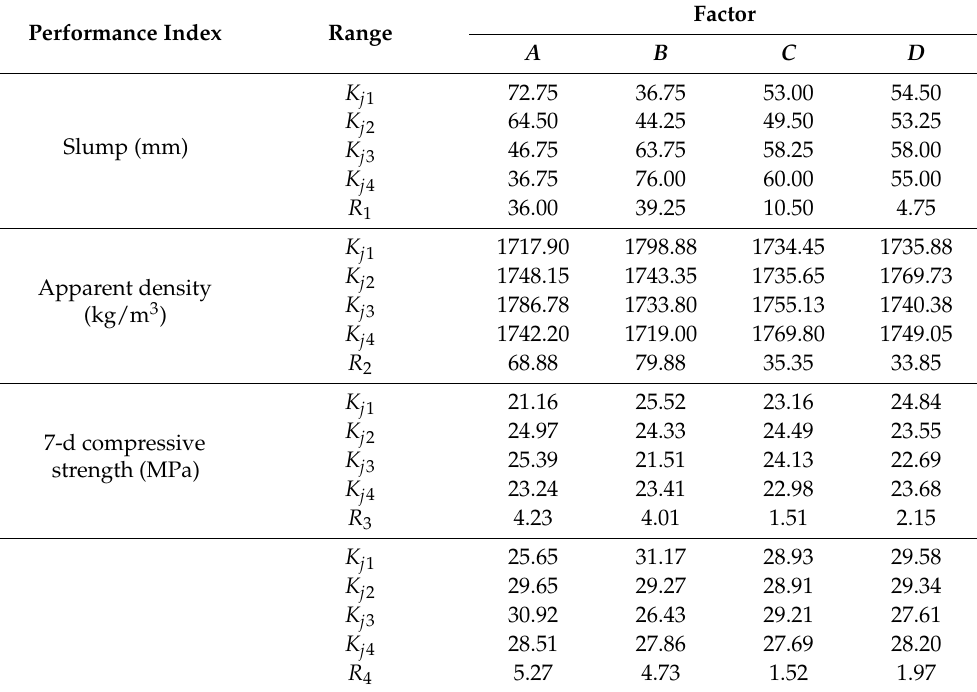
Table 8. The orthogonal range analysis of various factors.